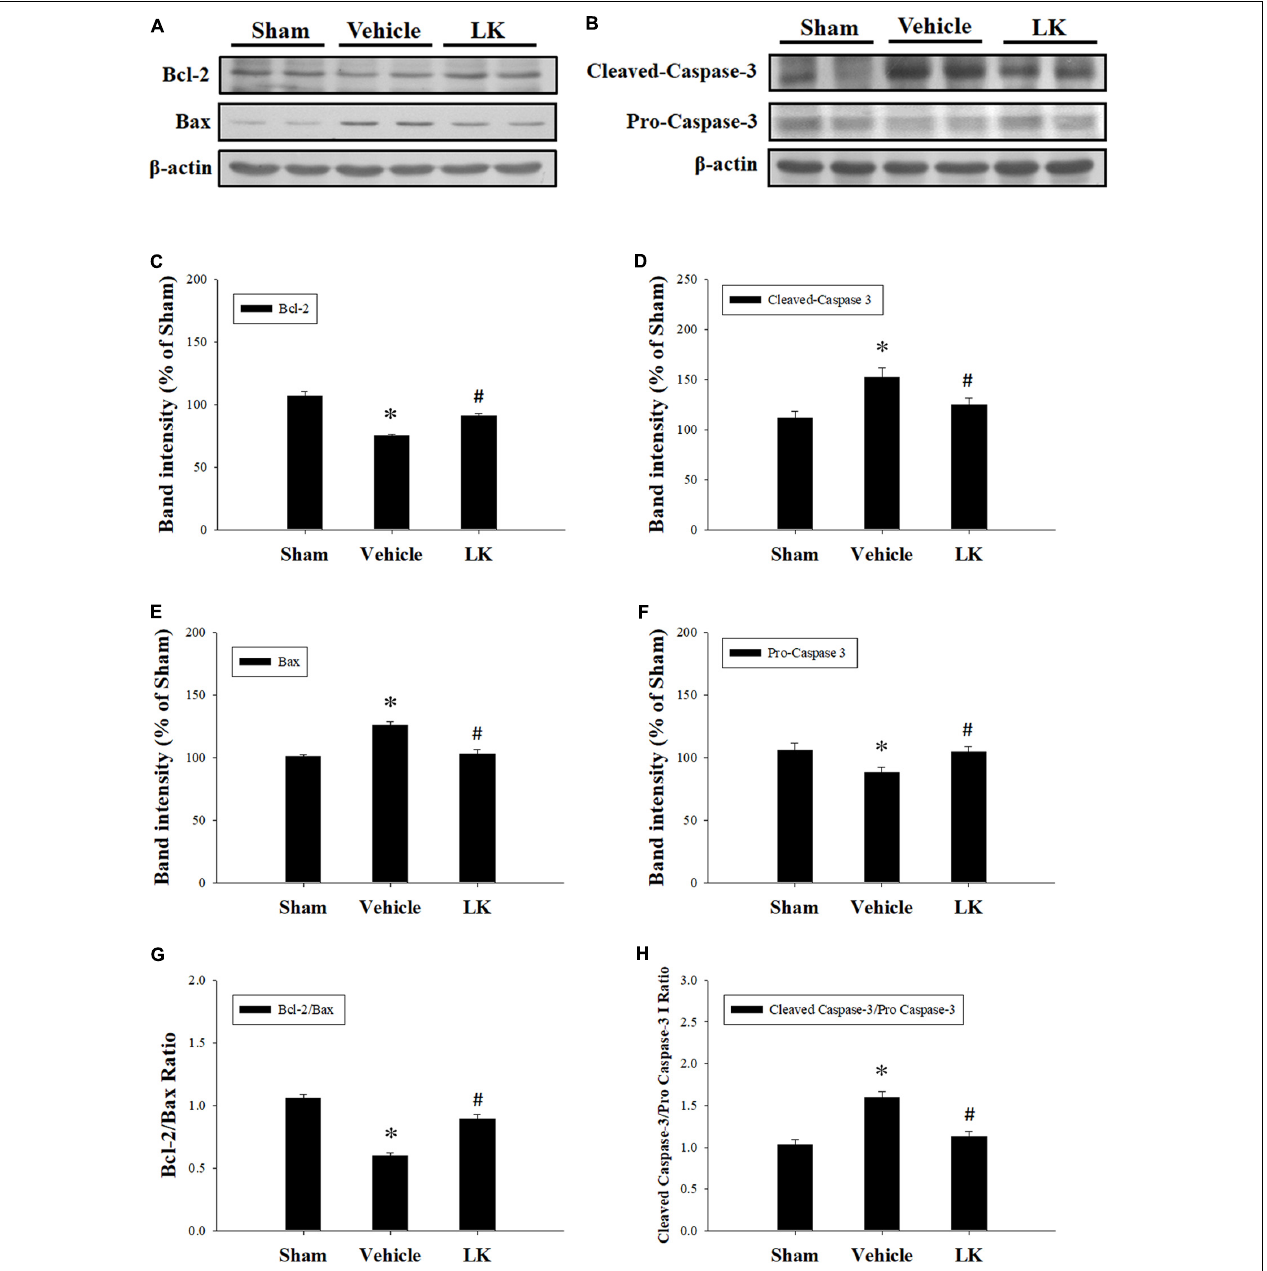
FIGURE 4 | Post-ischemic lumbrokinase treatment attenuated cardiomyocyte apoptosis in rats subjected to myocardial I-R injury. Representative immunoblot images of (A) Bcl-2 and Bax, and (B) Cleaved-Caspase-3 and Pro-Caspase-3. Quantitative densitometric analysis showing expression of (C) Bcl-2, (D) Bax, (E) the ratio of Bcl-2 to Bax, (F) Cleaved-Caspase 3 (G) Pro-Caspase-3 and (H) the ratio of Cleaved-Caspase 3 to Pro-Caspase-3 in rat myocardium after myocardial I-R injury. Data are normalized with values from the sham group and presented as percentage rates. Each value is represented as the mean ± SEM ( n = 3). ∗ p < 0.05 compared with the sham group; # p < 0.05 compared with the vehicle